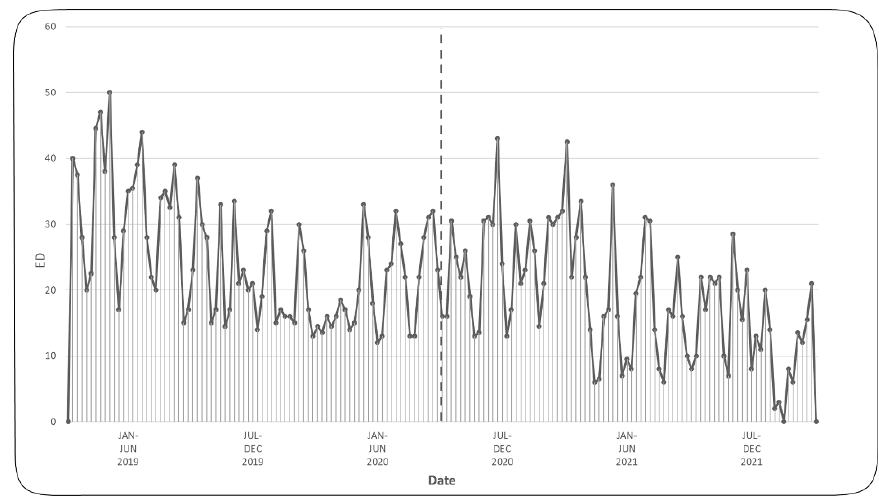
Figure 2. Distribution of effective dose across the study period. Linear histogram showing the distribution of effective dose across the study period (Midline: to separate pre- and post- optimization phases).